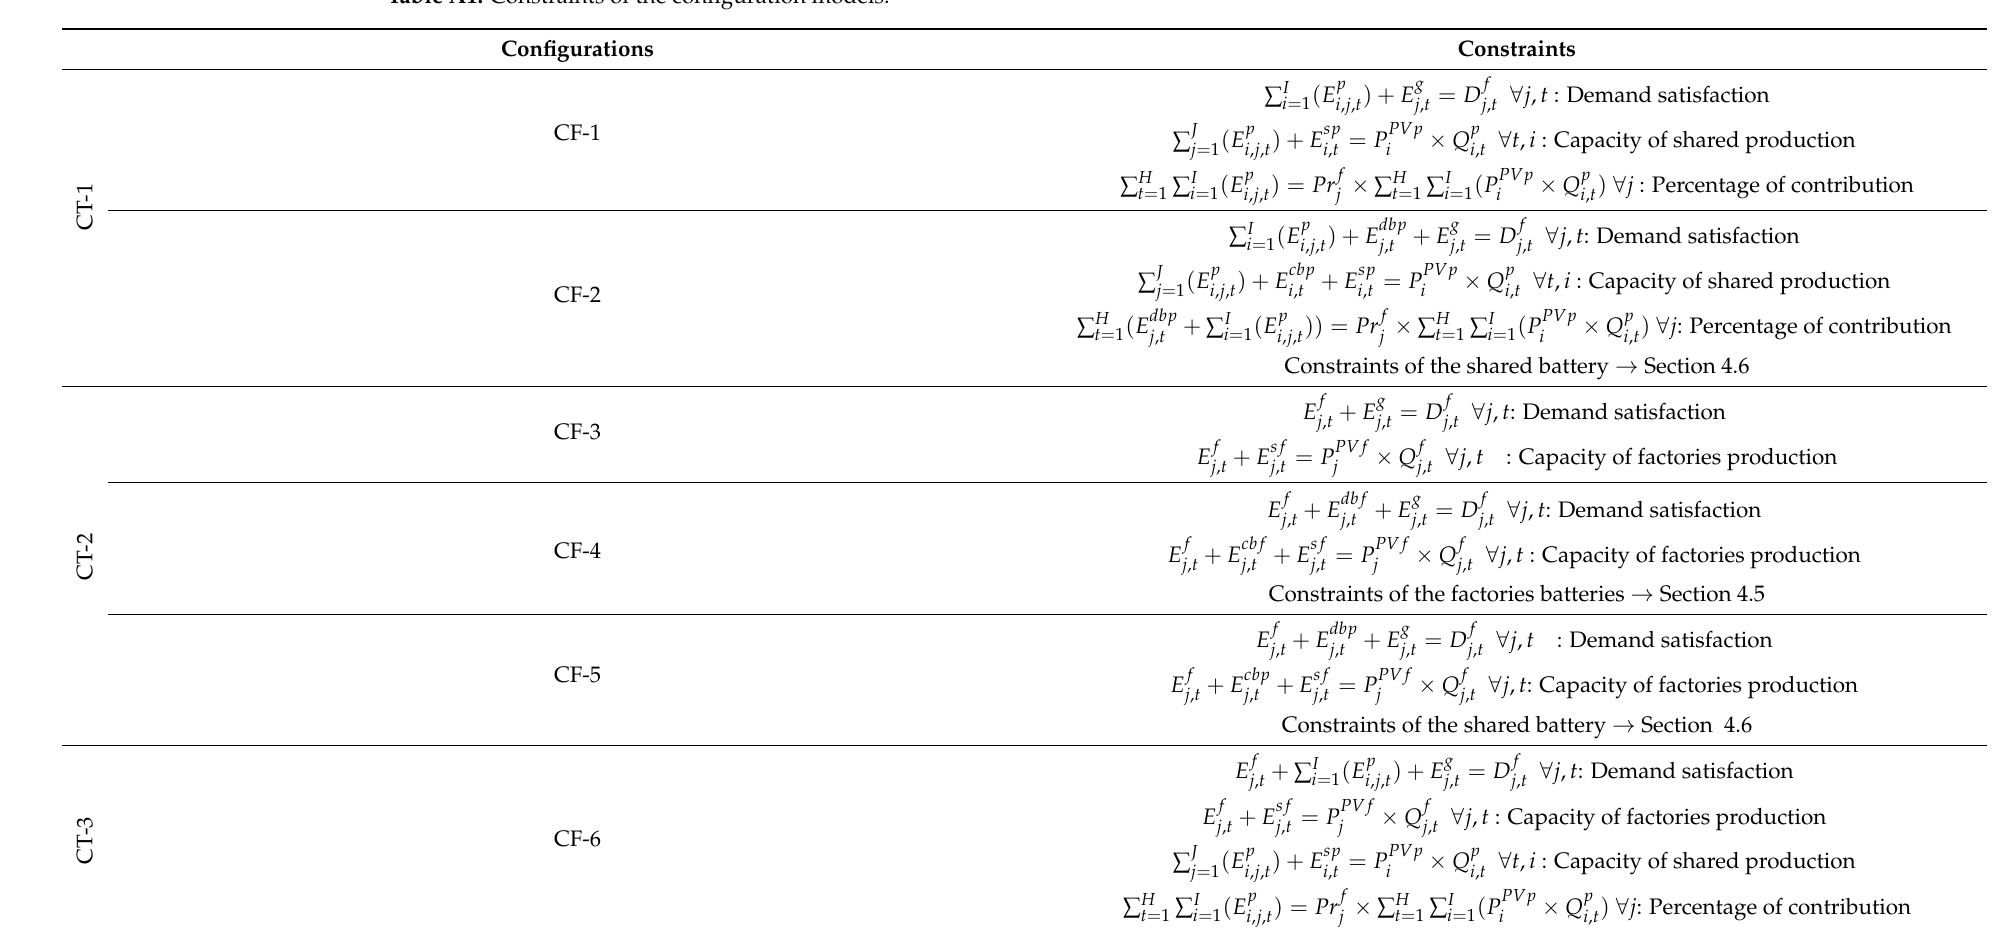
Table A1. Constraints of the configuration